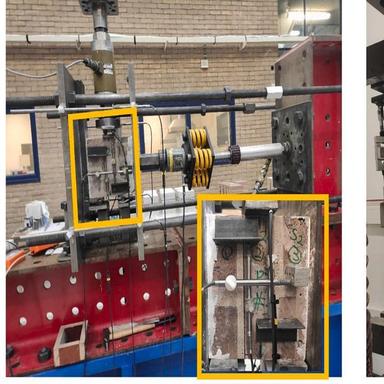
Test set-ups: (a) compressive tests on cores and prisms; (b) splitting tests on cores; (c) shear-compression tests on triplets; (d) bond wrench tests on couplets.